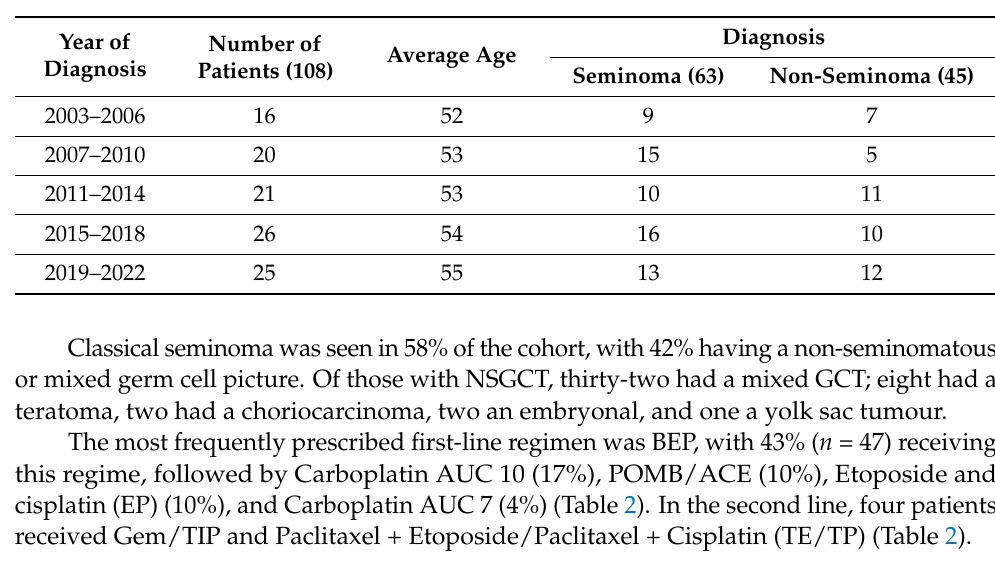
Table 1. Year of diagnosis and